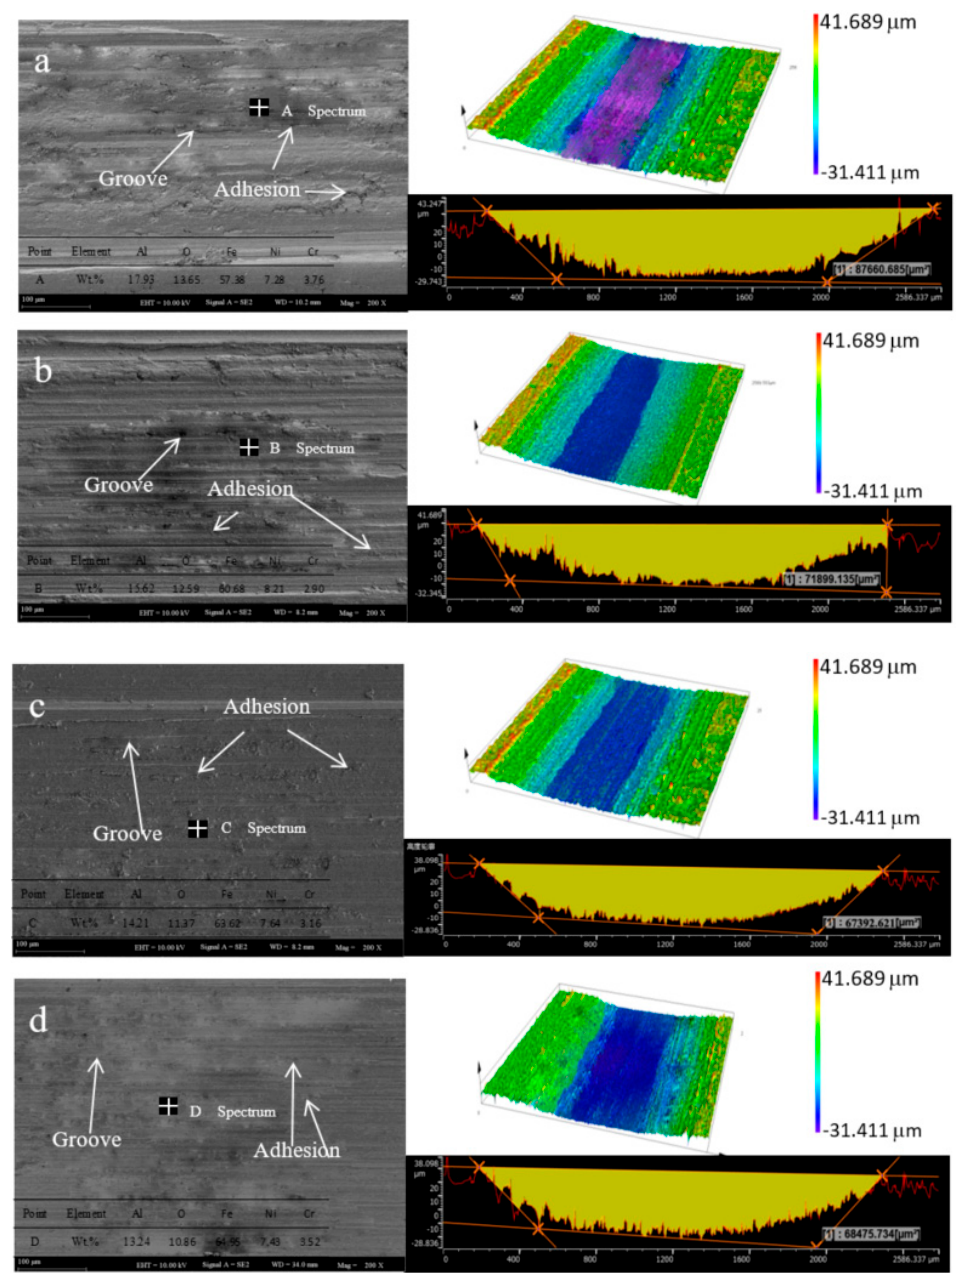
Figure 15. The 3D morphology and SEM image of the worn surface under load of 50 N: ( a ) M2 high speed steel; ( b ) the cladding layer was not tempered; ( c ) the cladding layer was tempered at 400 °C; and ( d ) the cladding layer was tempered at 600 °C.